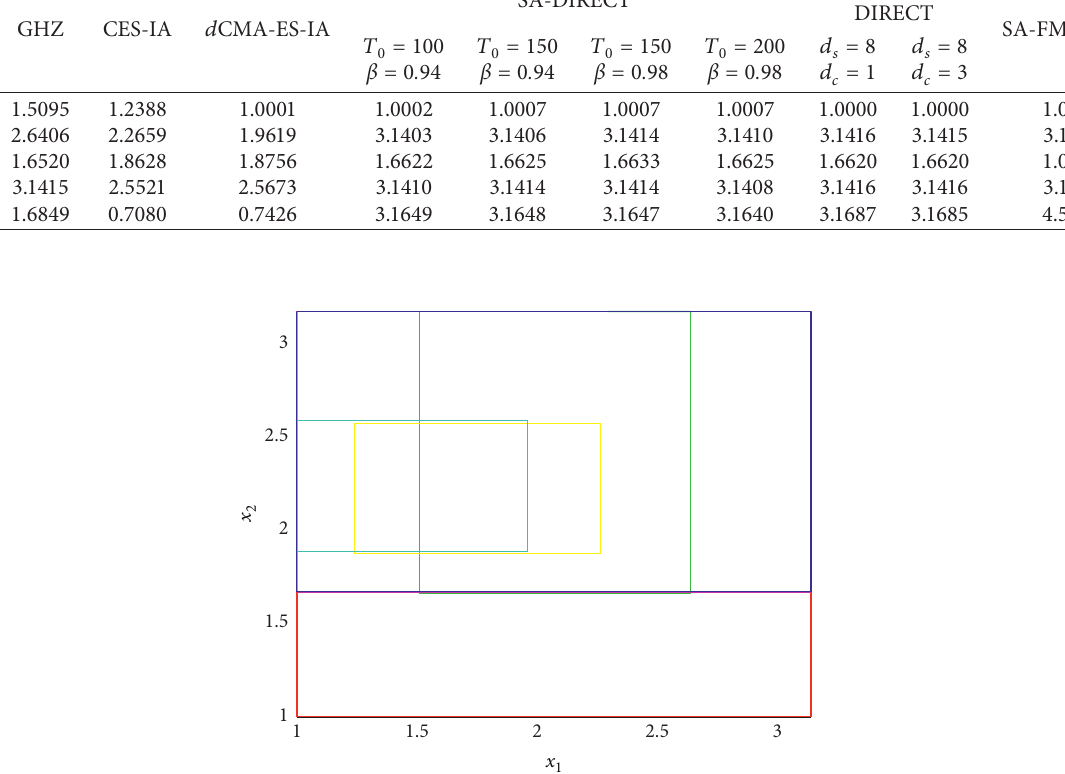
Figure 7: Example 2: the regions obtained by the following methods: the GHZ (green), CES-IA (yellow), d CMA-ES-IA (cyan), SA-DIRECT � 100 and β � 0 . 94 (blue), d CMA-ES-DIRECT with d with T 0